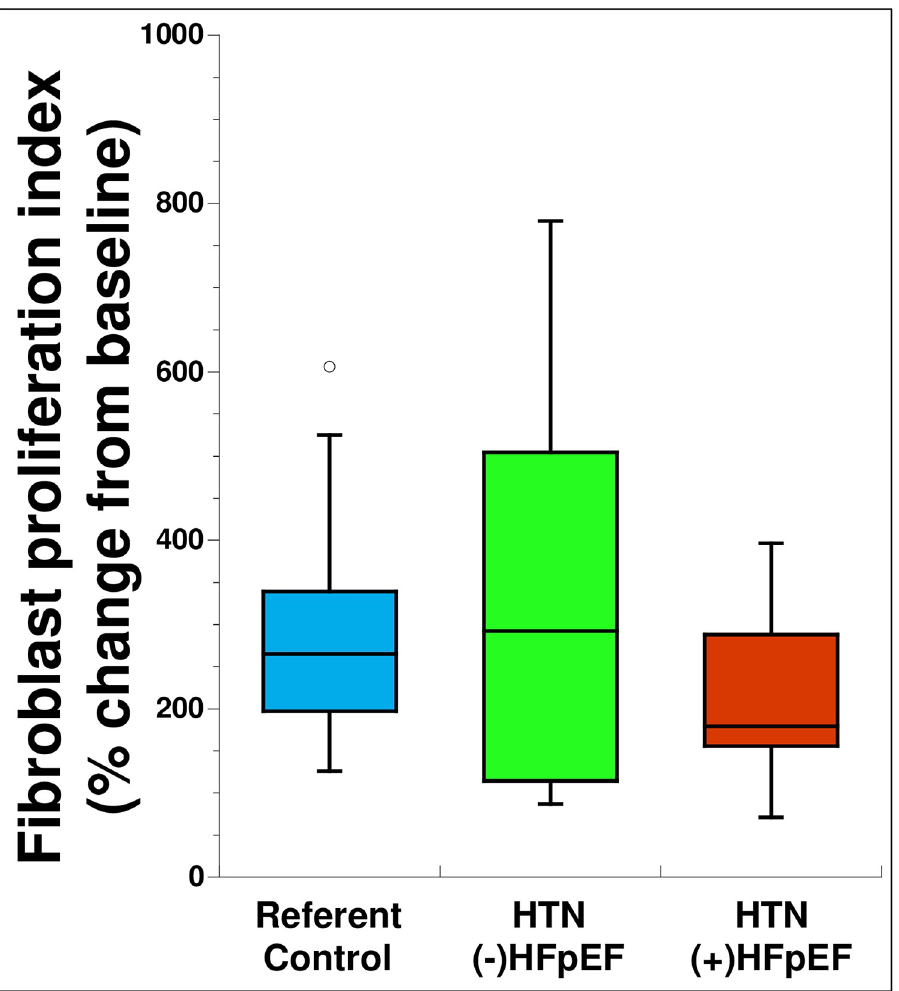
Fig 3. Fibroblast proliferation was assessed as described in materials and methods. No differences in proliferation were detected between the three groups. Proliferation assays were performed at P1 or P2 for each isolation. Blue: Referent control (n = 19), Green: HTN (-) HFpEF (n = 12), Red: HTN (+) HFpEF (n = 17). Open circles represent outlier